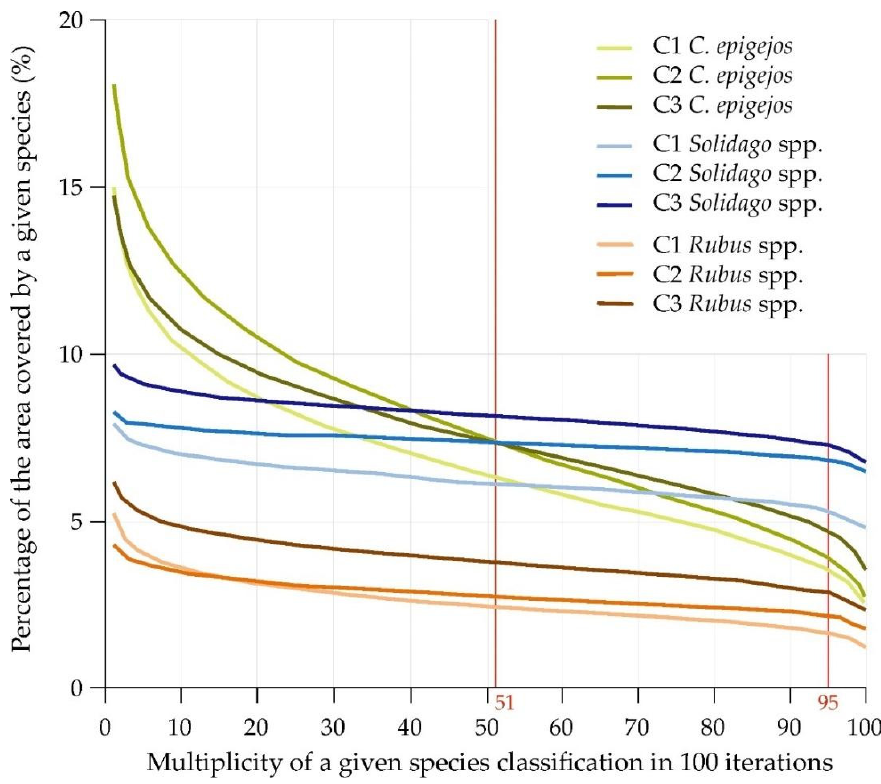
Figure 6. Relationship between threshold value and resulting area occupied by class.